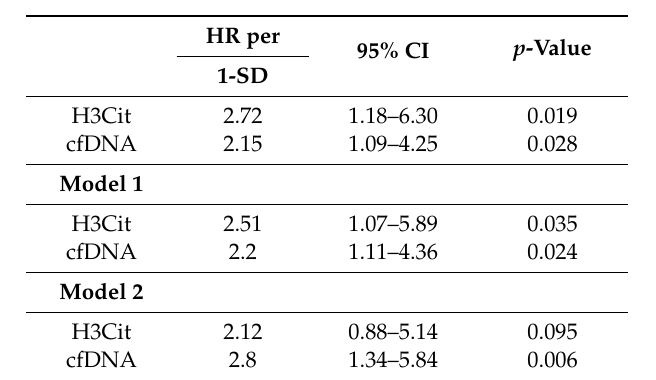
Table 2. Prognostic value of circulating H3Cit and cfDNA for the primary endpoint in univariate and multivariate Cox regression